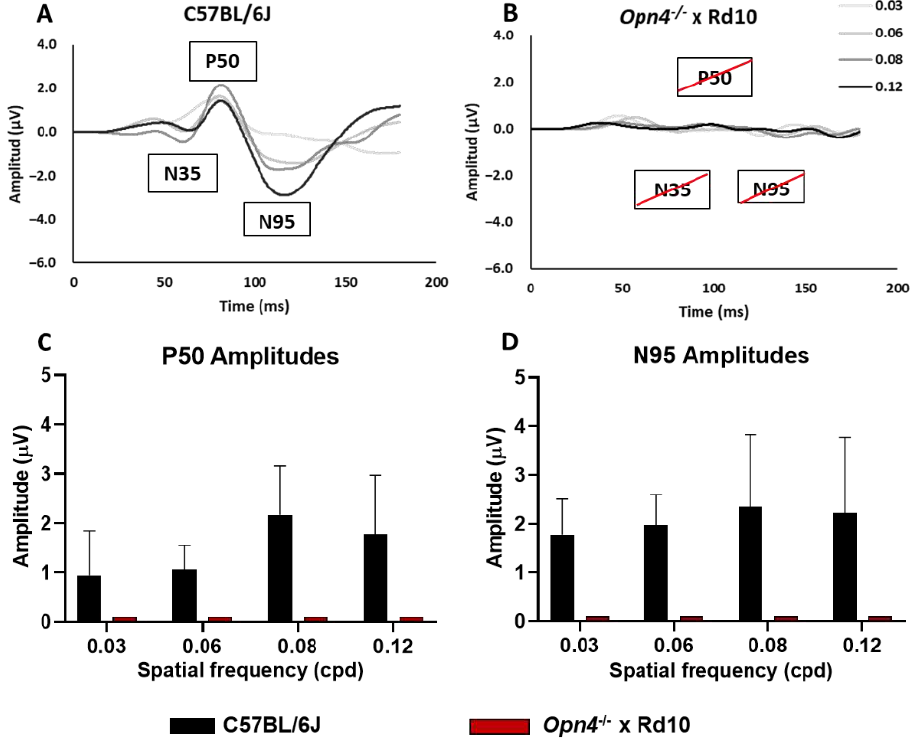
Figure 5. Pattern electroretinogram. Record of the waves corresponding to the strains C57BL/6J ( A ), and Opn4 − / − × Rd10 ( B ). Wave amplitude histograms P50 ( C ) and N95 ( D ). There are marked differences in the model Opn4 − / − × Rd10, compared to control ( p < 0.001). Data are presented as the mean ± SD.